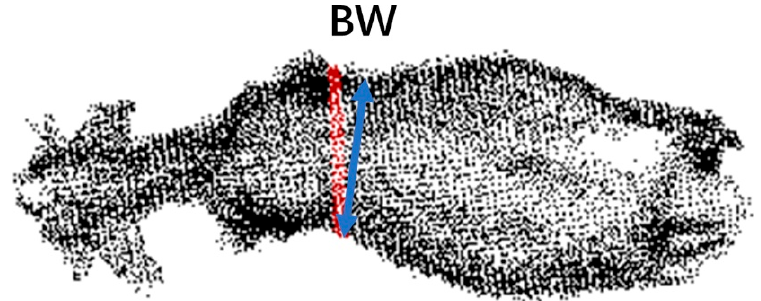
Figure 17. Calculated body widths of the beef cattle.